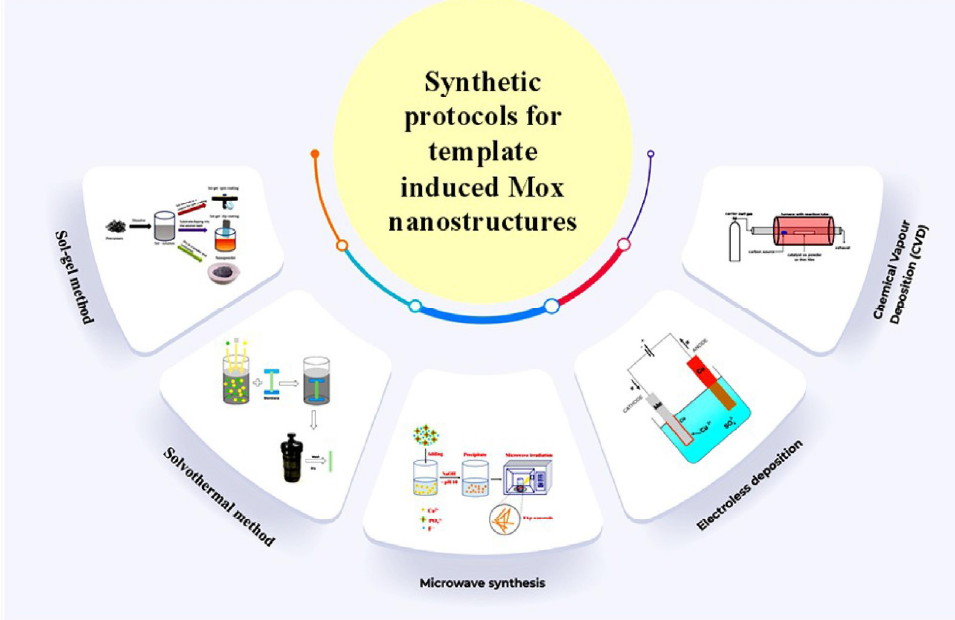
Figure 4. Synthetic protocols for the fabrication of template-assisted MOx nanostructures. Reprinted with permission from Ref. [56]. Copyright 2022 Elsevier.